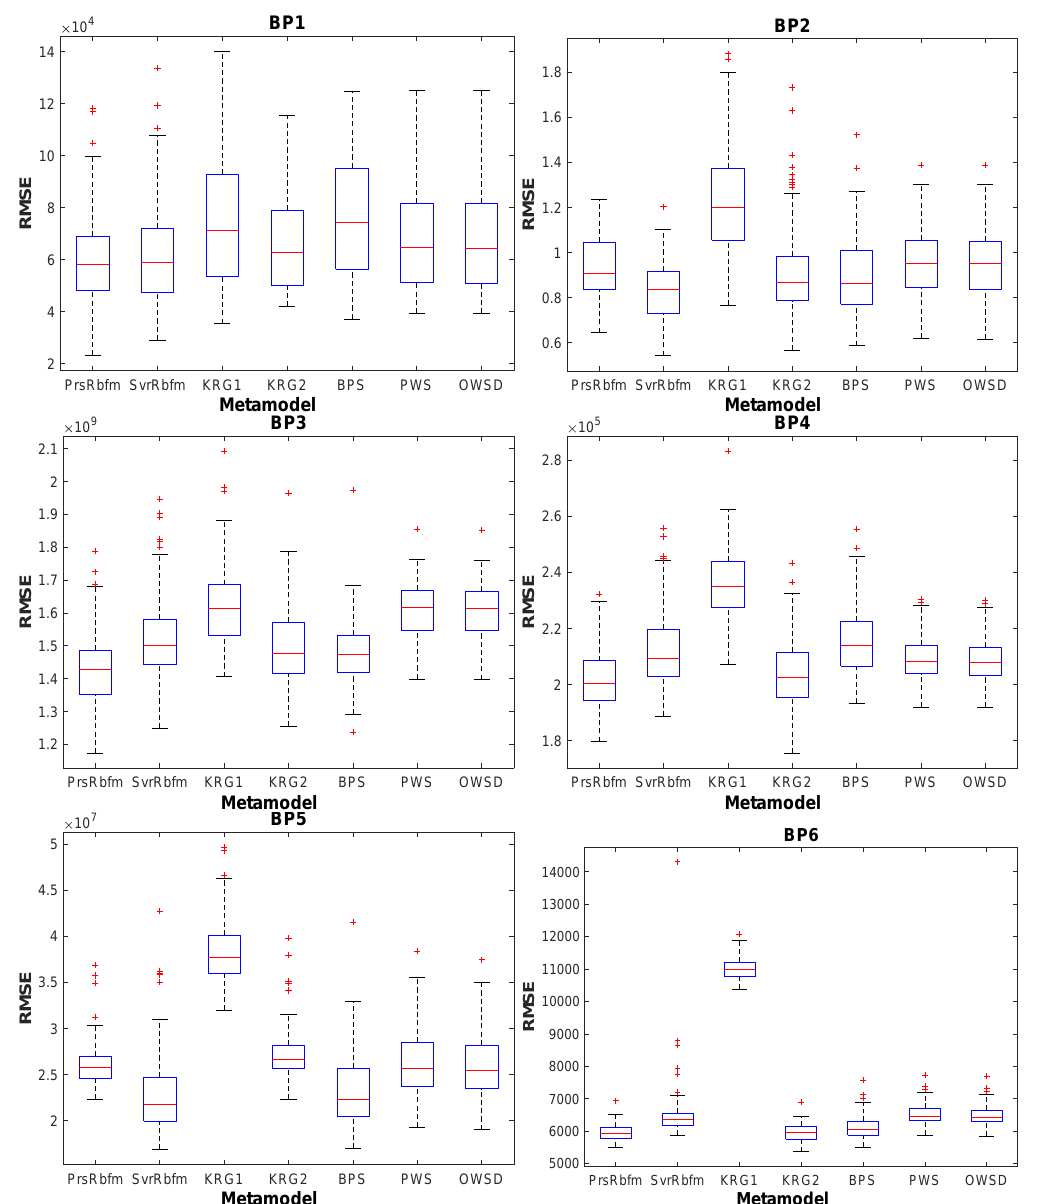
Figure 6. Boxplots of RMSE of PrsRbfm, SvrRbfm, KRG1, KRG2, BPS, PWS, and OWSD for the benchmark